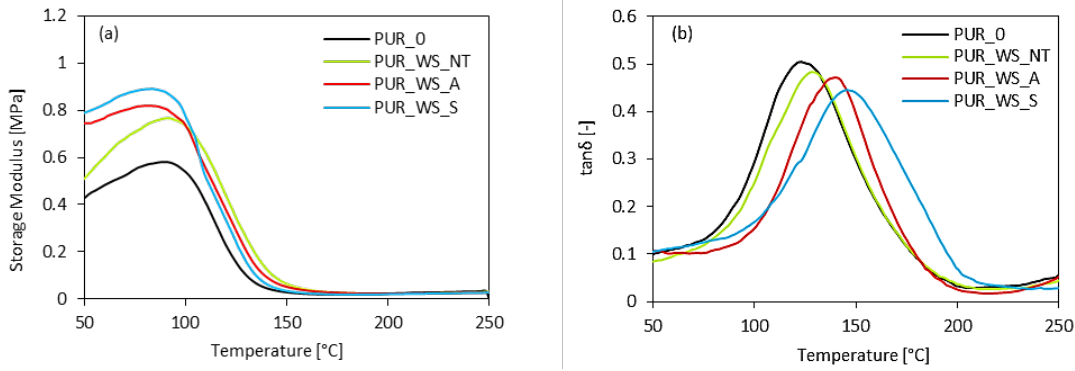
Figure 8. ( a ) Storage modulus and ( b ) tanδ of PUR foams.